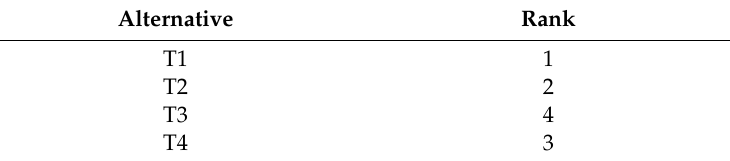
Table 18. Final ranking of dozers by